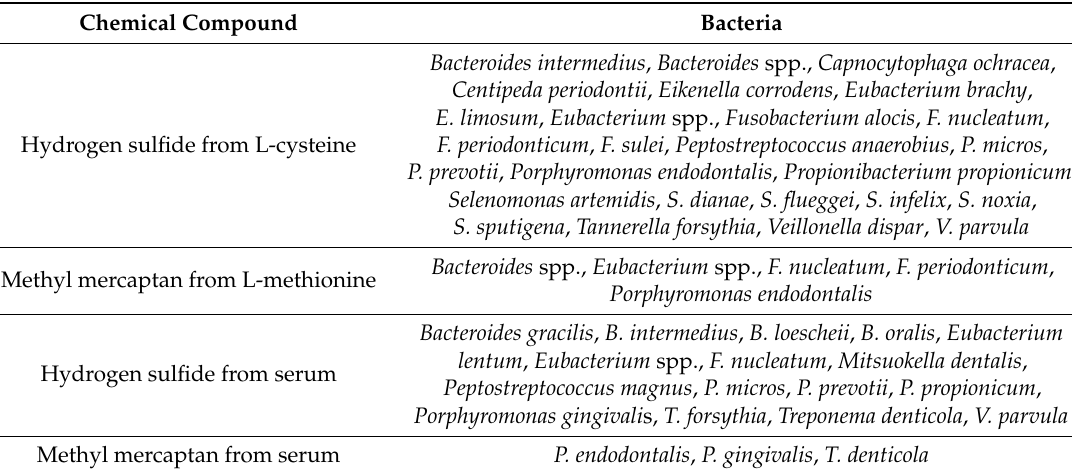
Table 2. Bacterial producers of volatile sulfur compounds (VSC)